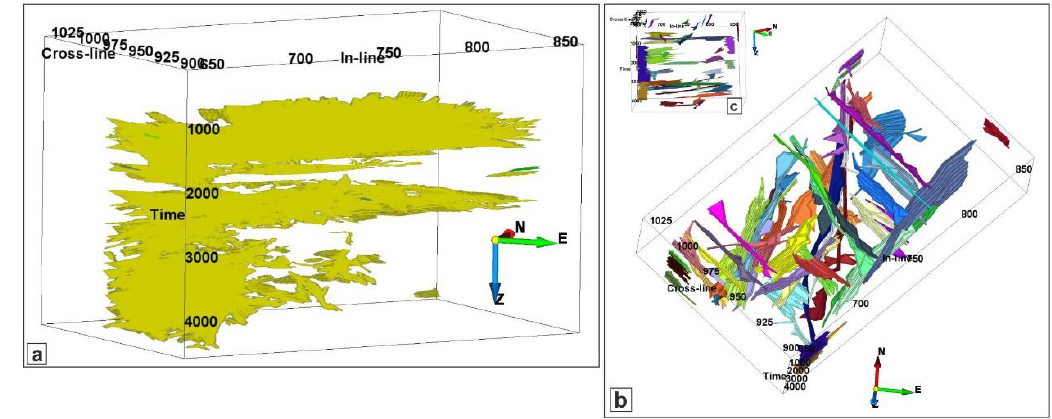
Figure 8. ( a ) Voxel connectivity filter (VCF) ranked fracture bodies, ( b ) bird’s-eye view of the fracture surfaces and sticks, and ( c ) crossline view of the fracture surfaces and sticks.